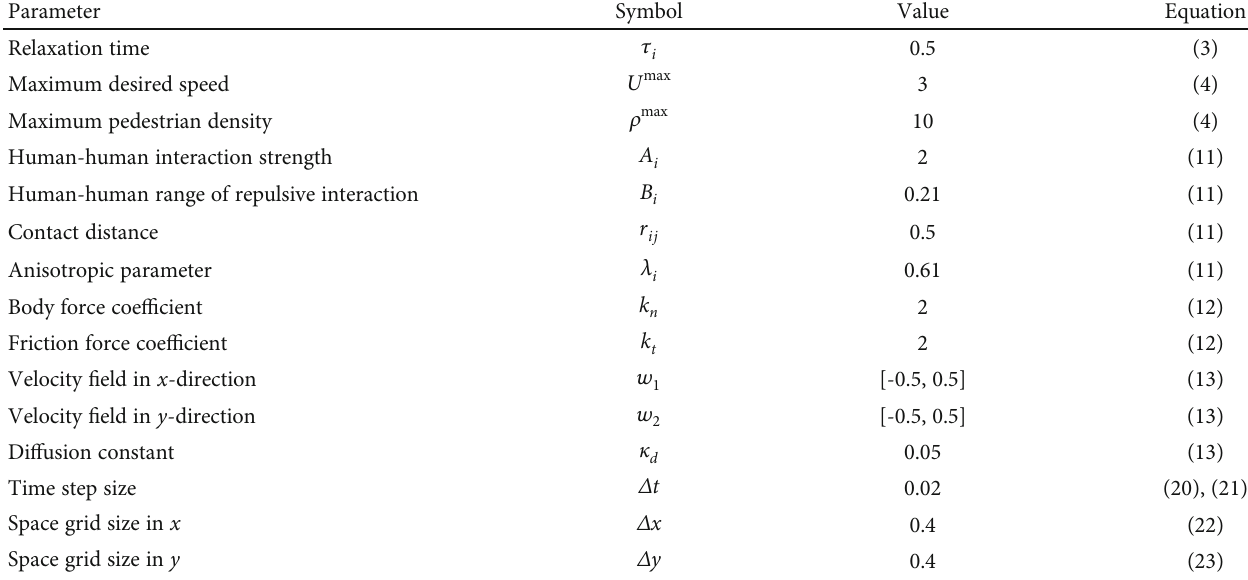
Table 1: Parameters for evacuation simulations.